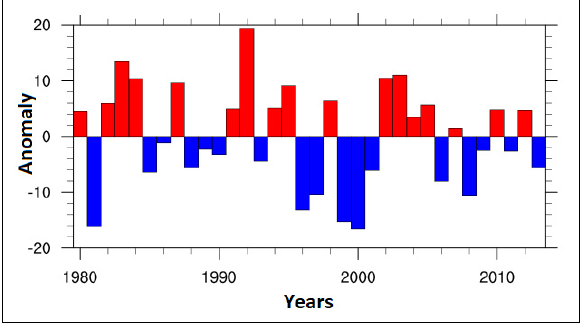
Figure 5: The Standardised Rainfall Index for Zimbabwe time series for the period 1980 to 2013.